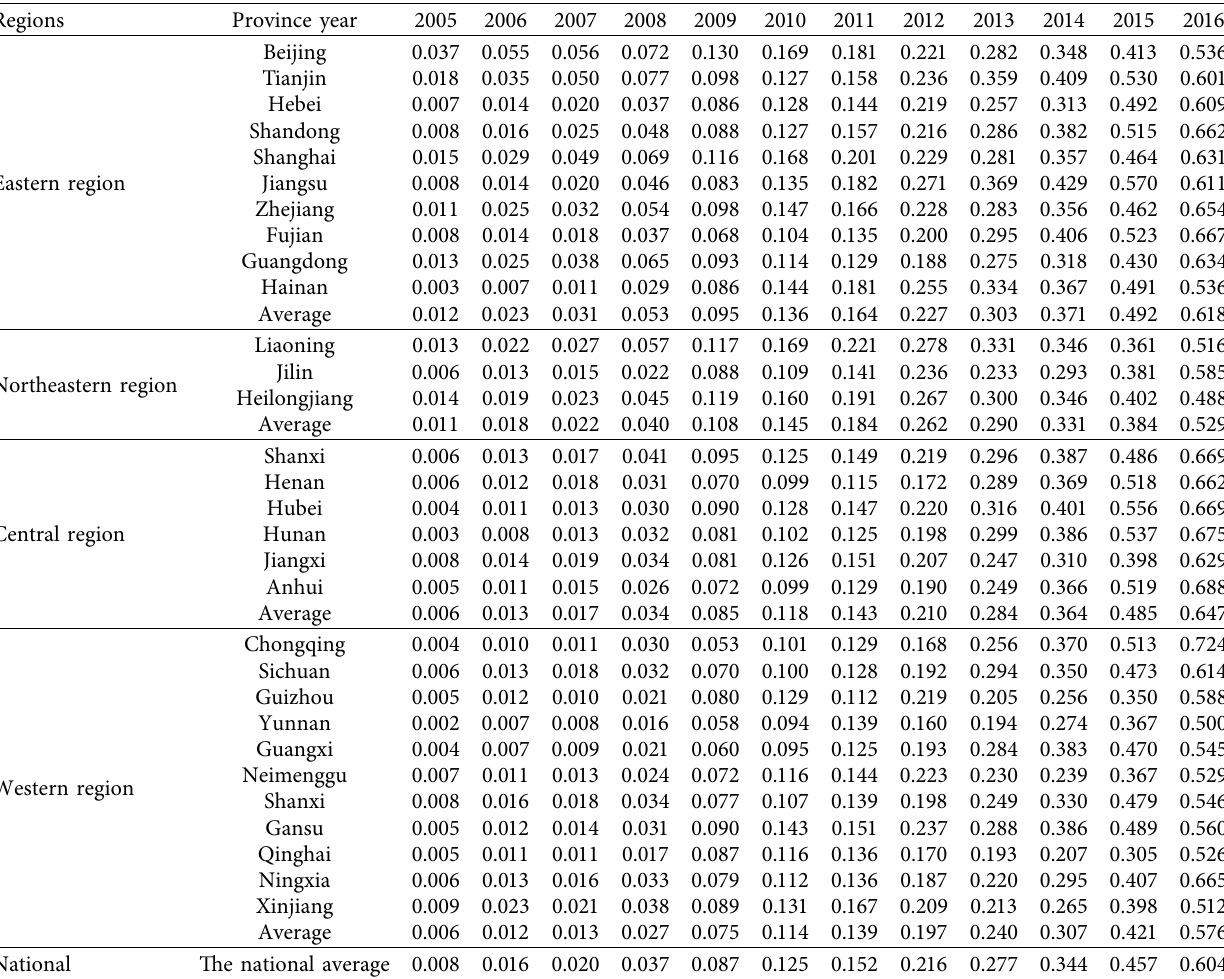
Table 4: Coupling coordination level of green economy, education development, and technological innovation.